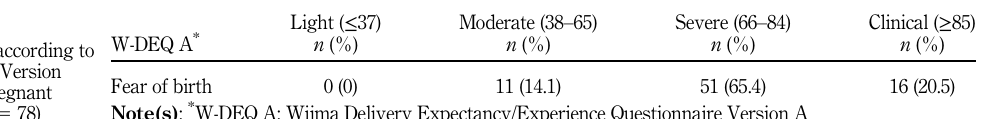
Table 4. Birth fear according to W-DEQ A Version score of pregnant women ( n 5